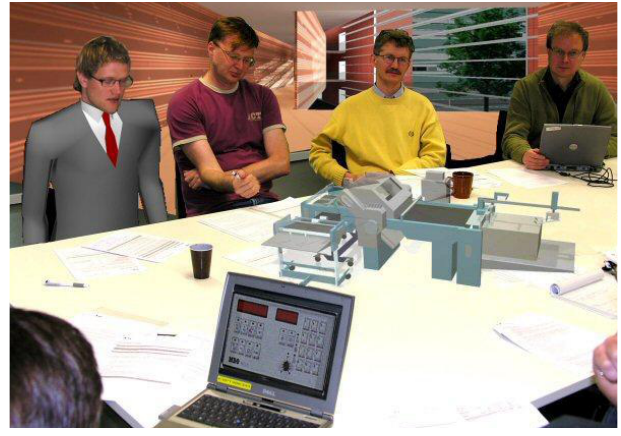
Figure 3. Participants share a virtual object in ACME